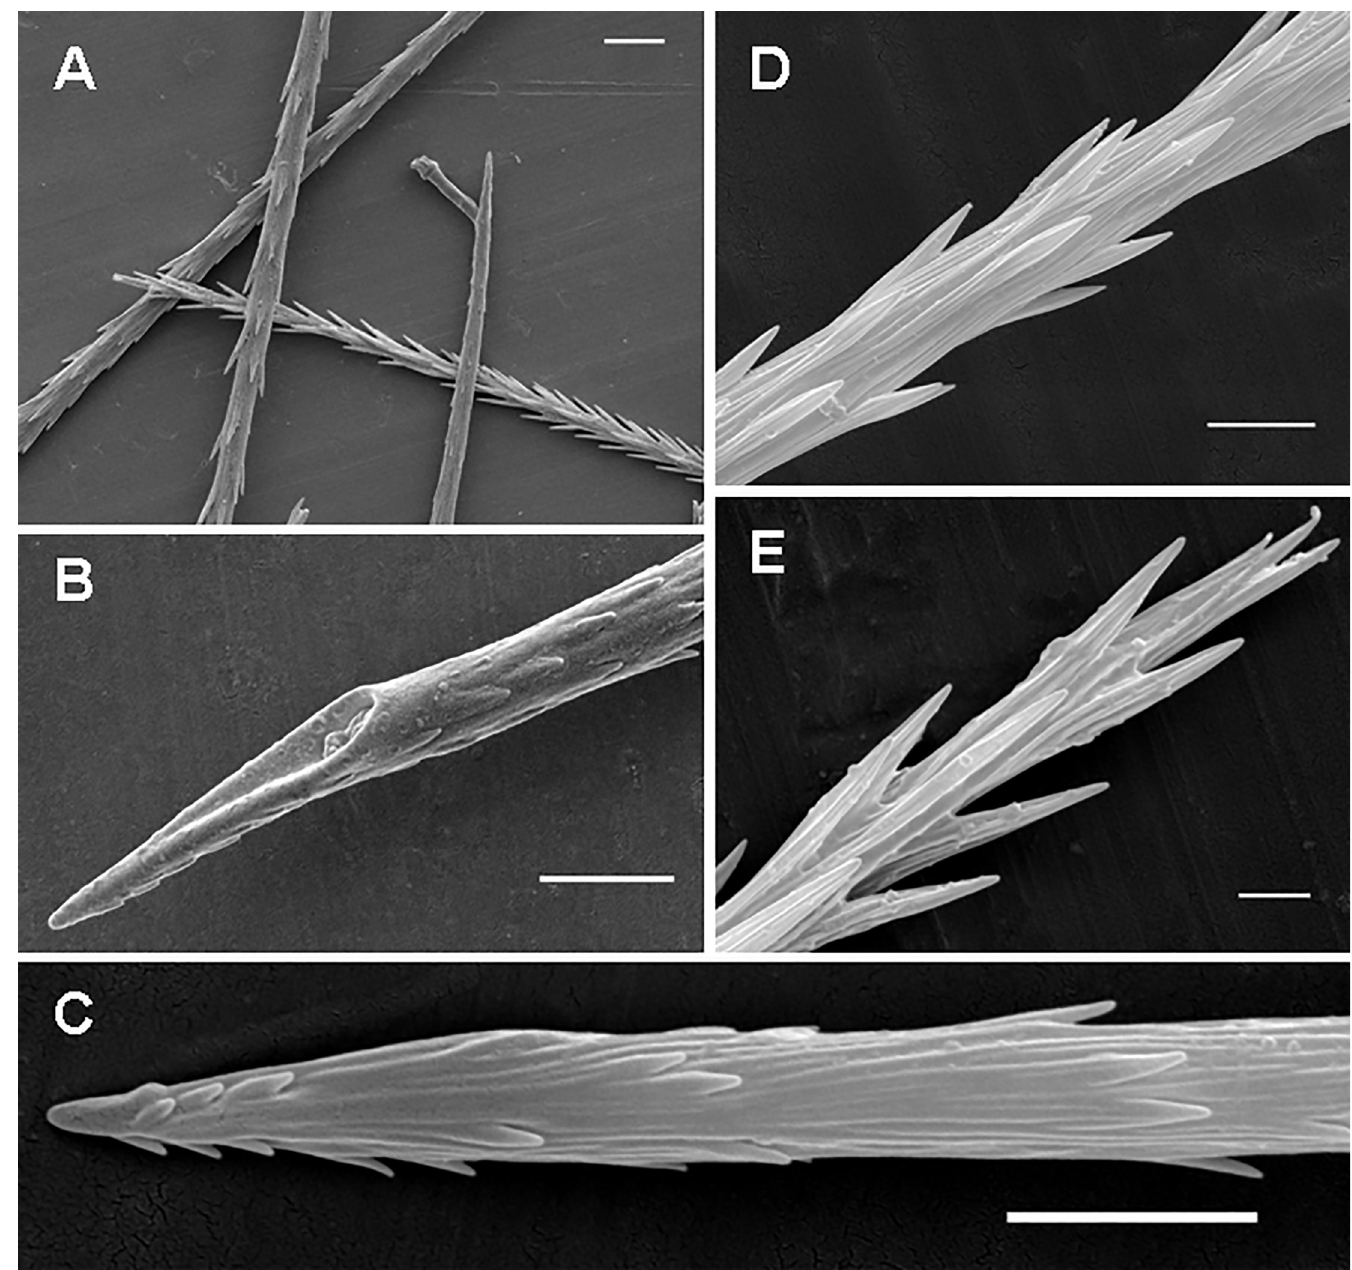
Fig 14. Urticating setae of type VI. ( A) Hemirrhagus papalotl , female. Type VI, two midsections with short, more confluent barbs, apical section with longer and more protruding barbs, basal section with a supporting stalk. Scale bar = 10 μ m. (B) Hemirrhagus eros , female. Type VI, the basal section with a socket for supporting stalk. Scale bar = 5 μ m. (C) Hemirrhagus papalotl , immature male. Type VI, detail of the basal section. Scale bar = 5 μ m. (D) Hemirrhagus papalotl , immature male. Type VI, detail of the midsection. Scale bar = 5 μ m. (E) Hemirrhagus papalotl , immature male. Type VI, detail of the apical section. Scale bar = 2 μ m.